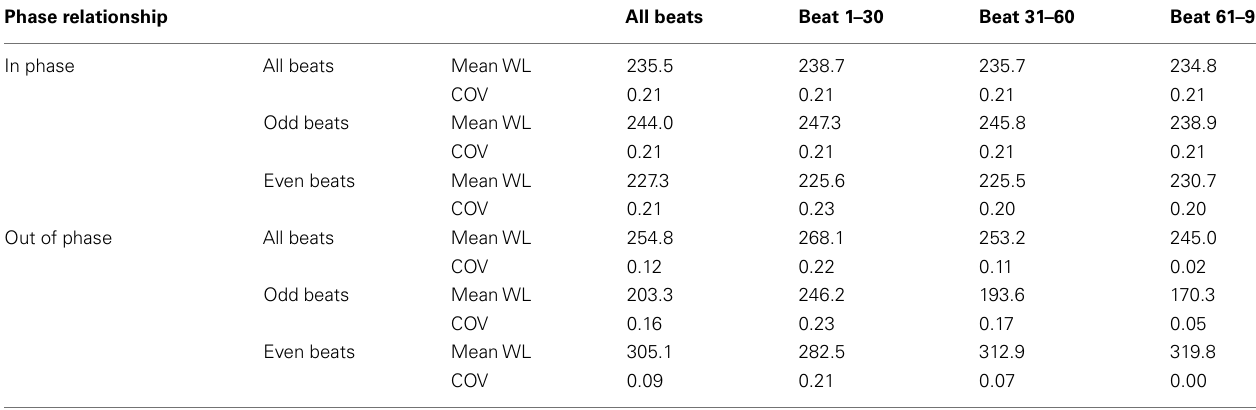
Table 2 | Mean wavelength (WL) and coefficient of variation (COV) computed for in phase and out of phase